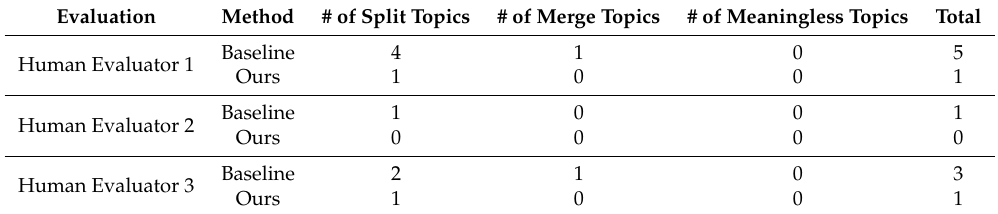
Figure 4. The Rouge–1 results of the baseline and proposed methods. Table 5. Results of clean topics.